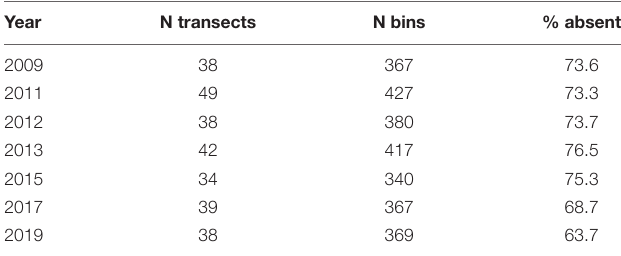
TABLE 1 | Summary of acoustic-trawl survey data available for